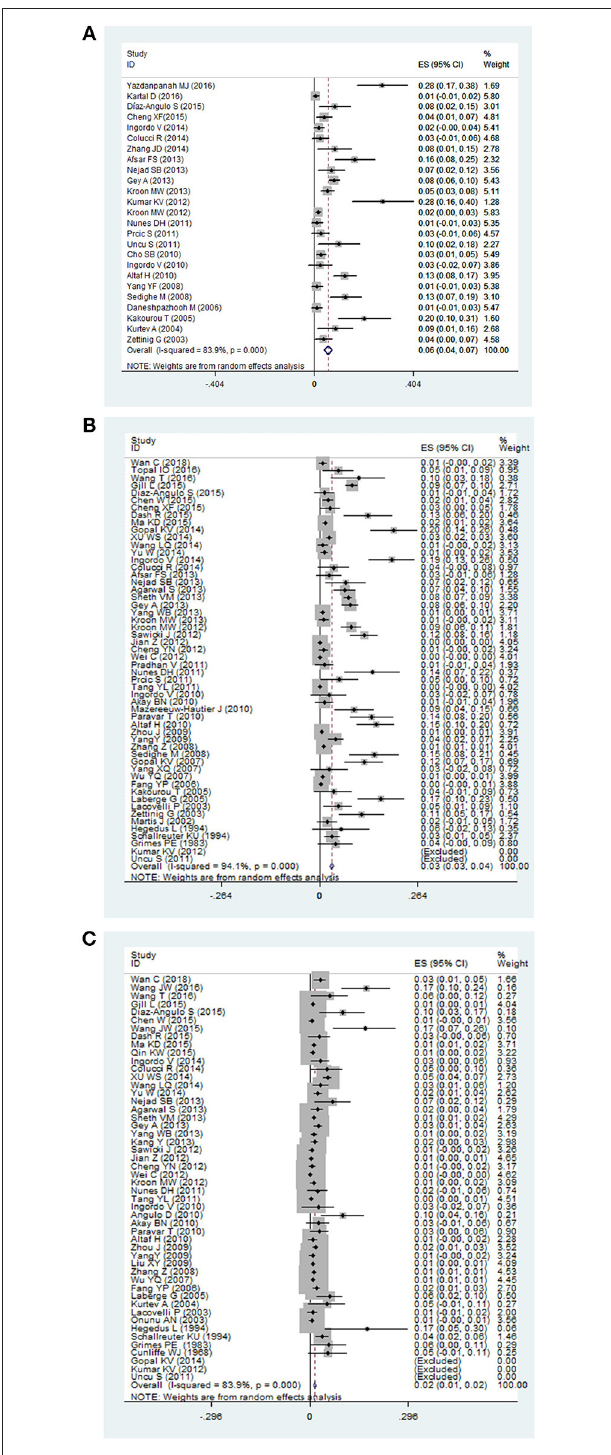
FIGURE 2 | The forest plot of three thyroid disorders in vitiligo patients. The highest prevalence was reported in (A) subclinical hypothyroidism, and a majority of investigators paid attention to (B) overt hypothyroidism, and (C) overt hyperthyroidism in vitiligo